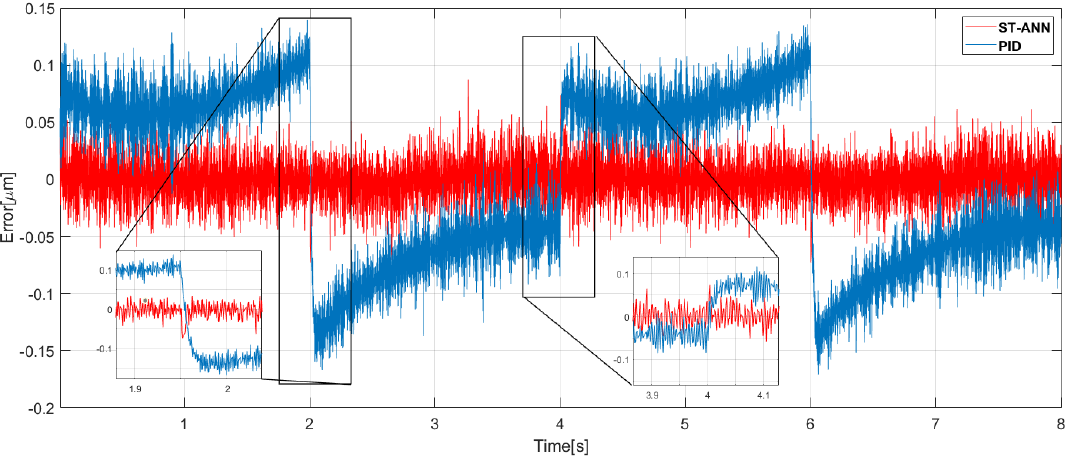
Figure 7. Error comparison between the ST-ANN and the PID